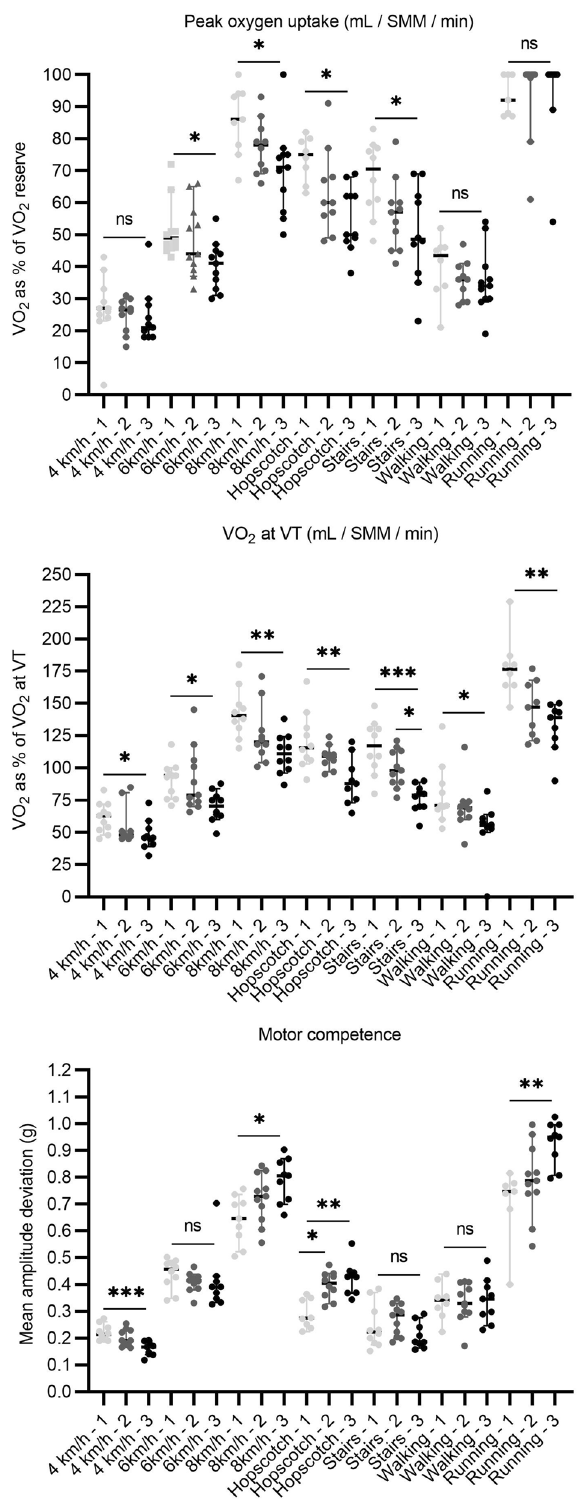
Figure 1. Differences in the different measures of physical activity intensity indices among the thirds of measures physical fitness and motor competence. * p < 0.05, ** p < 0.01, *** p < 0.001, ns = statistically insignificant. VO2 = oxygen uptake, VT = ventilatory